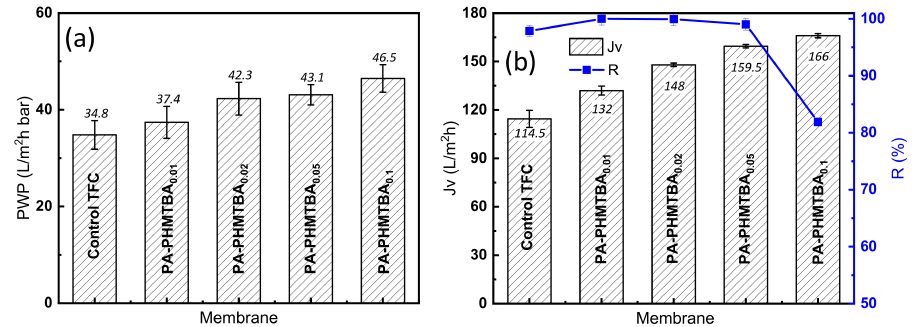
Figure 7. ( a ) Permeance and ( b ) selectivity of prepared TFC